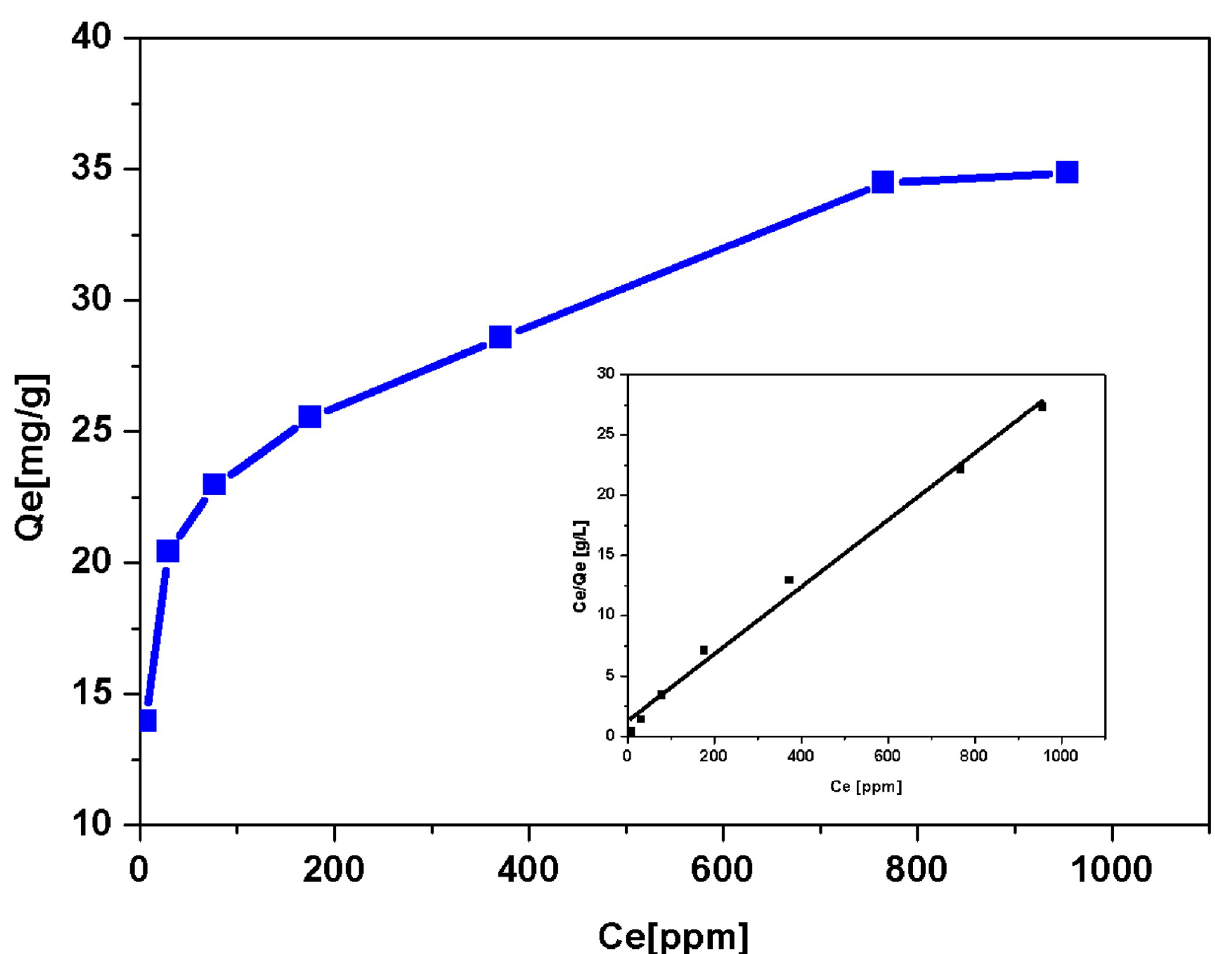
Fig 5. The isotherm of Ni(II) adsorption onto MSBC. Reaction conditions: Initial concentration of Ni(II) 20–1000 ppm at pH 7, 50 ml of solution, 50 mg of MSBC, 24 h, 25 ˚C.